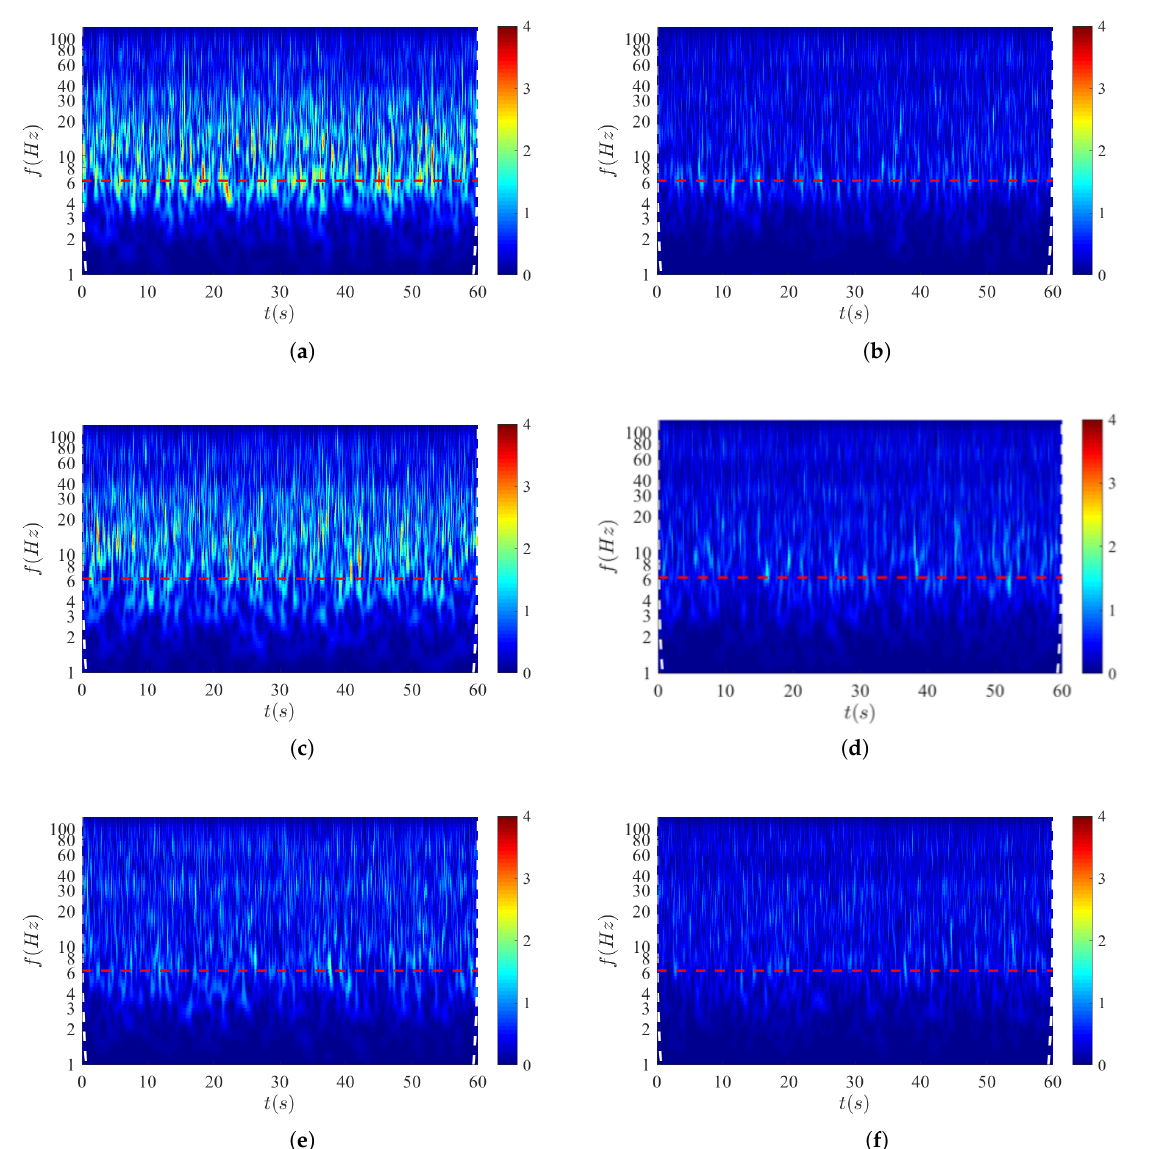
Figure 17. Wavelet analysis for signal from Microphone 16: ( a ) natural flow, ( c ) best compromise; and ( e ) maximum DR. For Microphone 13: ( b ) natural flow; ( d ) best compromise; and ( f ) maximum DR. Plots are color-coded according to the magnitude of the wavelet transform of the corresponding pressure